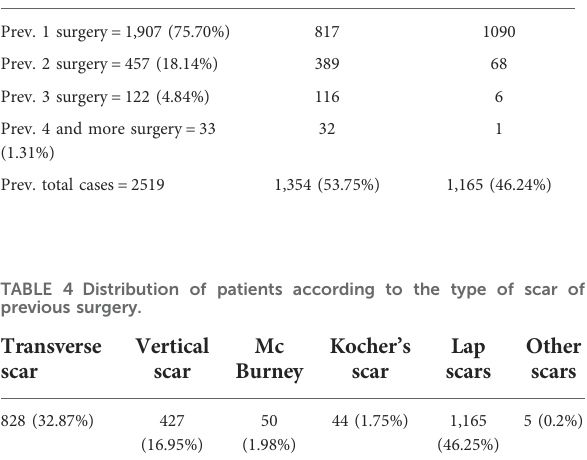
Table 5 : We split the previous surgery patients into those with gynae indication ( Table 5A ) constituting 84.2% (2,121 out of 2,519) and general surgery cases ( Table 5B ) constituting 15.79% cases (398 out of 2,519). Table 5A : In the gynae group, open procedure with 55% (1,168 out of 2,121) was 10% more prevalent than the laparoscopic procedure with 45% (953 out of 2,121). In the laparotomic approach, previous cesarean sections constituting 71.74% (838 out of 1,168) were the most common, followed by ectopic pregnancy (8%, i.e., 92 out of 1,168), both of which had a substantial rate of adhesions. Endometriosis (1%) and